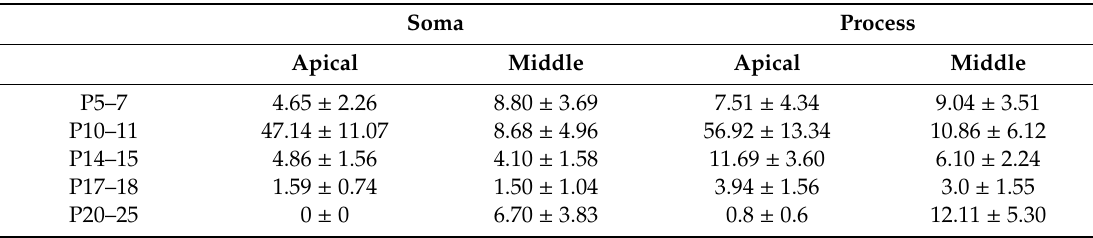
Table 2. Spontaneous intracellular Ca 2 + activity in Deiters’ cell somas and phalangeal processes in the di ff erent ages and cochlear turns (10 − 2 events / min.; mean ±